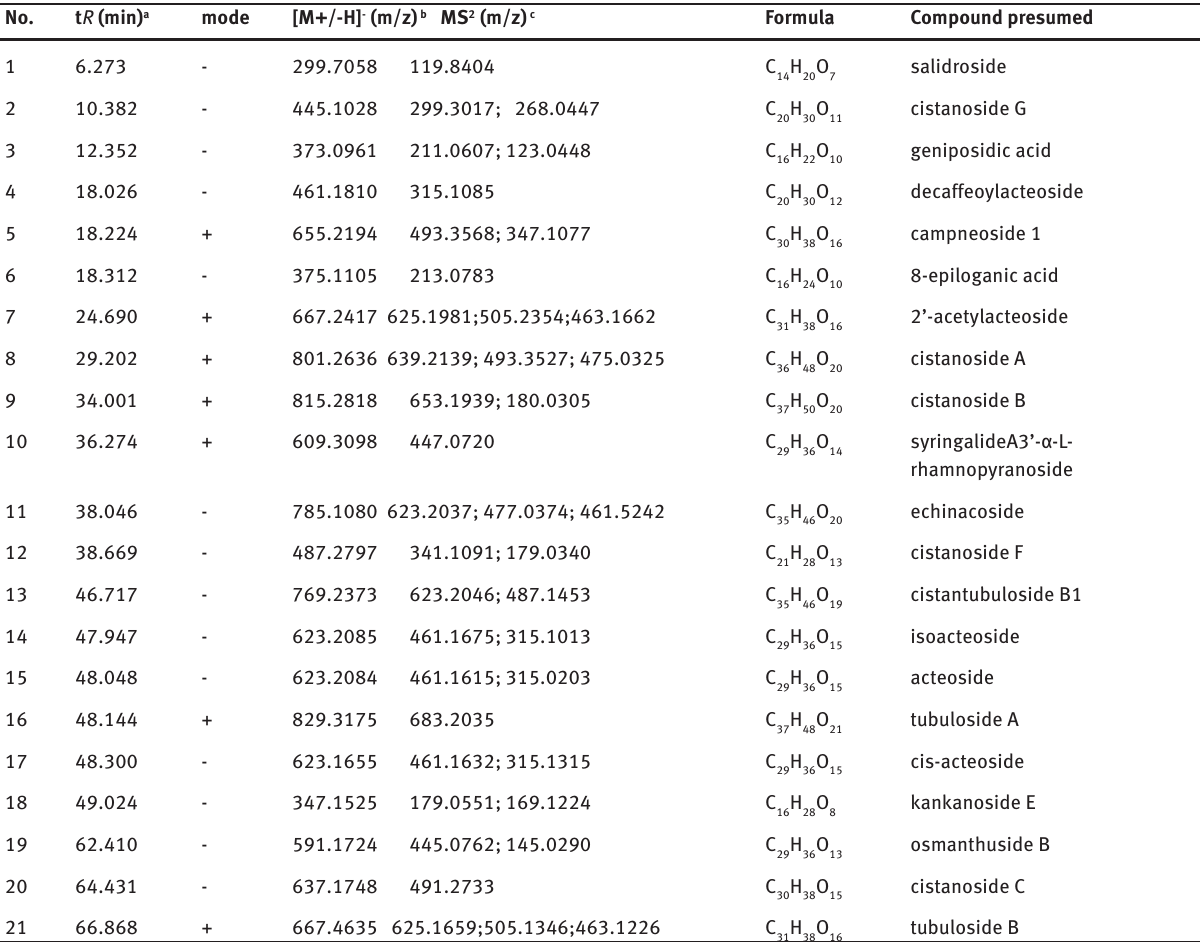
Table 4: Tentative assignments of LC peaks in positive and negative ion modes.